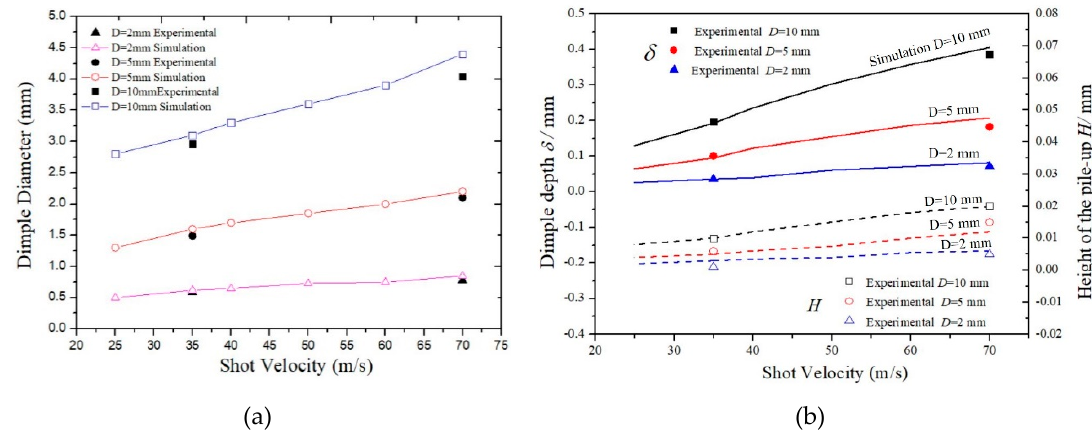
Figure 6. Evolutions of the dimensions of the dimple as a function of the shot velocities: ( a ) the dimple diameter; ( b ) the dimple depth and height of the pile-up.